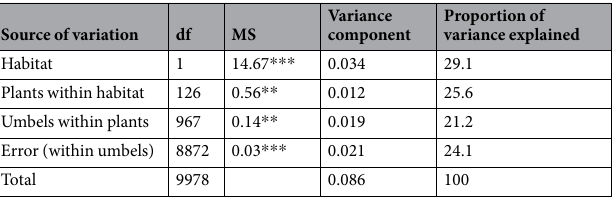
Table 3. Results of three-level nested analysis of variance testing for effect of habitat, individuals, and umbels on seed mass in Peucedanum oreoselinum . *** p < 0.001, ** p < 0.001 (Tukey’s